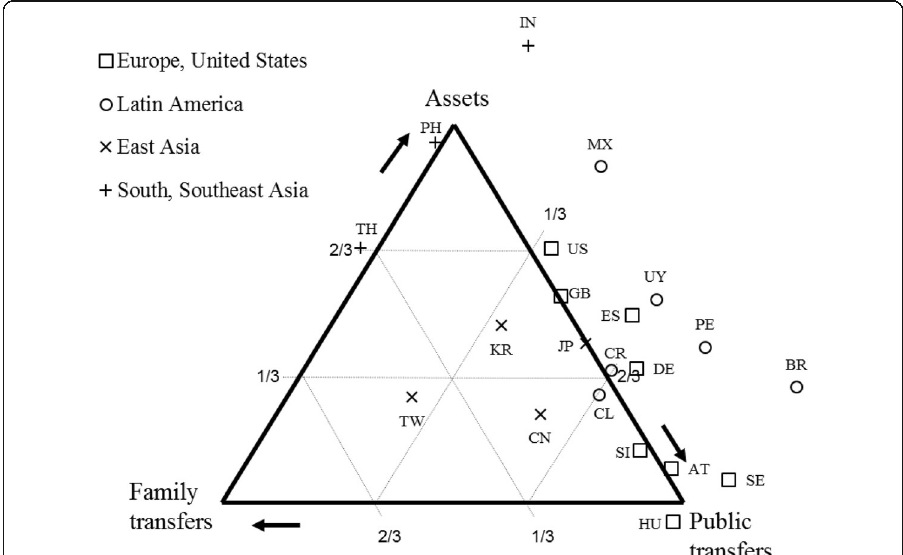
Fig. 3 How consumption net of labor income is funded for the elderly. Funding shares of family transfers, public transfers, and asset income (sum to 1.0). Source: Drawn from National Transfer Accounts data for each country. See ntaccounts.org. The United Nations ’ two-letter country labels are used to identify the data points (see list of